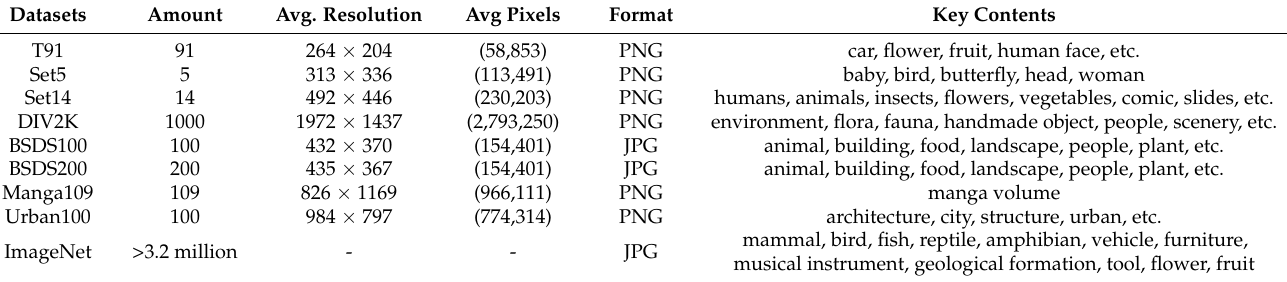
Table 1. Characteristics of datasets (modified from Wang, Chen and Hui [3]).